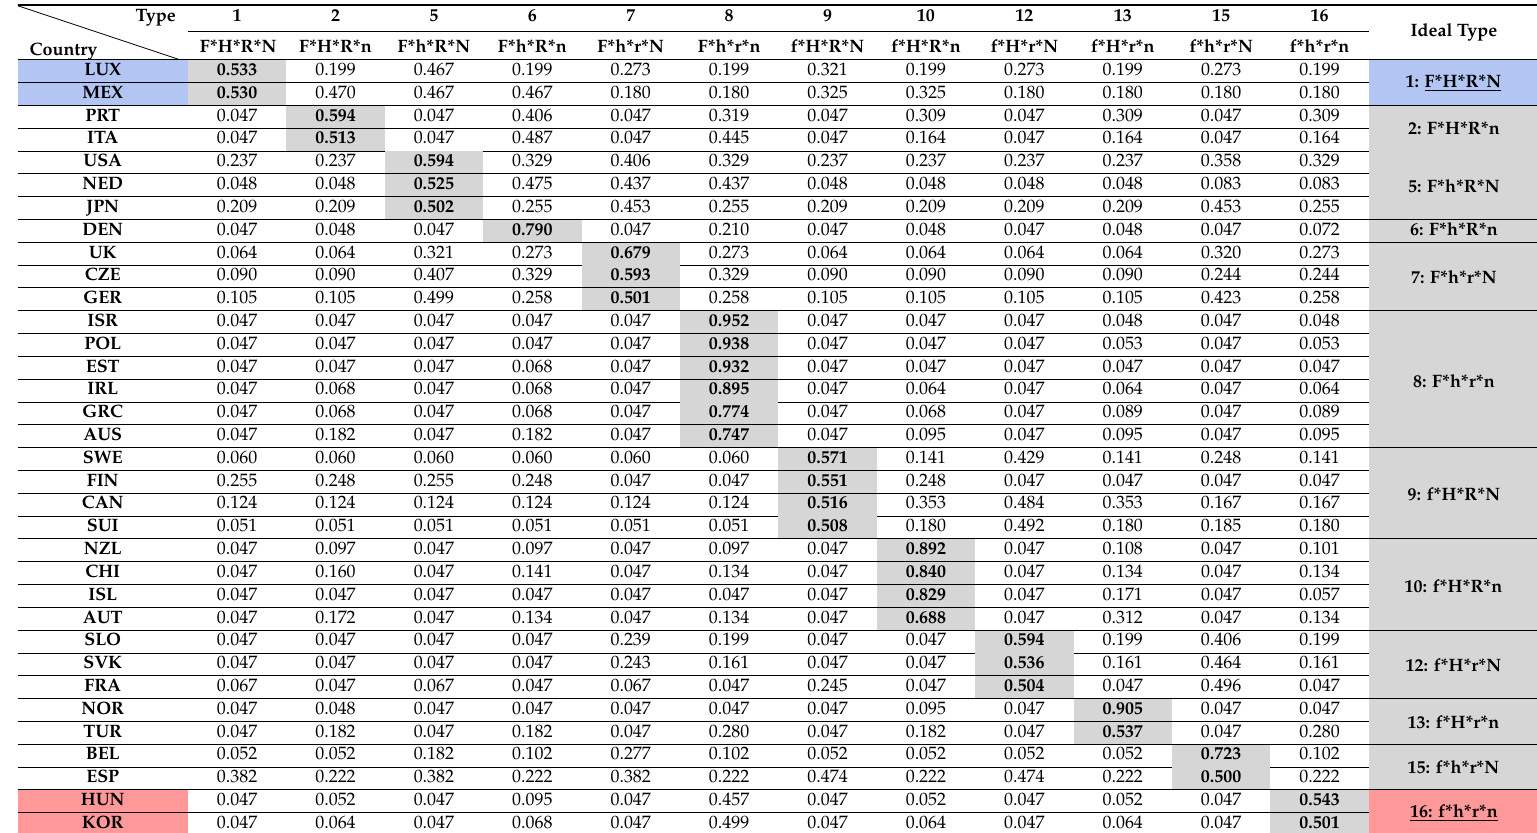
Table 4. Results of Fuzzy-set ideal type analysis by OECD countries